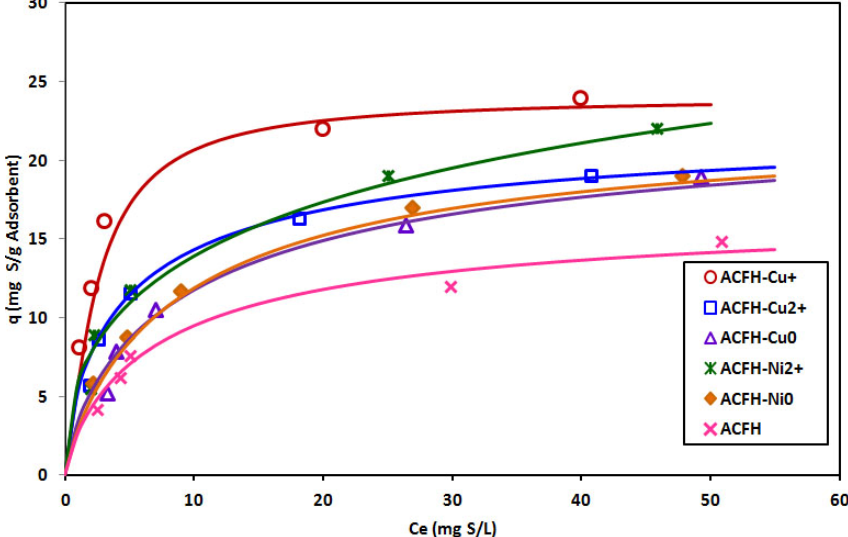
Figure 5. Adsorption isotherms of 4,6-DMDBT onto activated carbon fibers impregnated with different copper and nickel species. Solid lines represent Langmuir-Freundlich fit of the data.